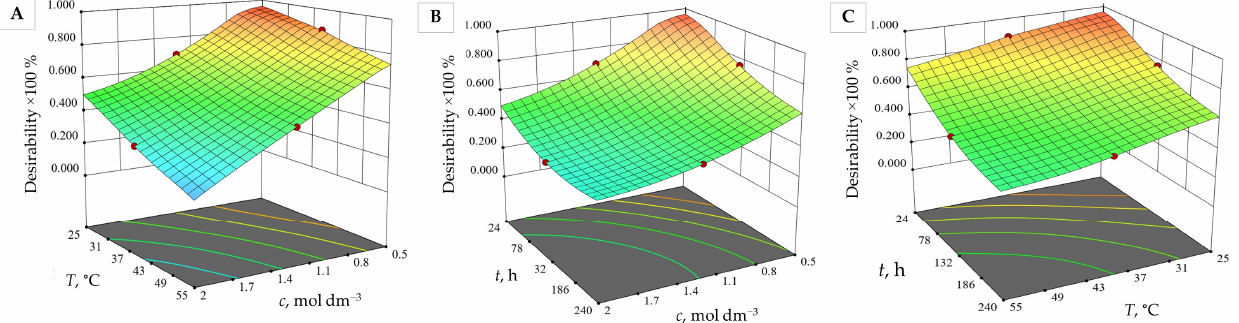
Figure 8. Desirability function of the amount of eluted ions and alumina ceramic density dependent on ( A ) nitric acid concentration and temperature at constant time (132 h), ( B ) time and nitric acid concentration at constant temperature (40 °C), and ( C ) time and temperature at constant nitric acid concentration (1.25 mol dm –3 ).